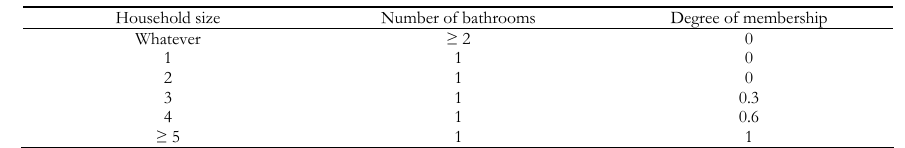
Household size and number of bathrooms of the residence